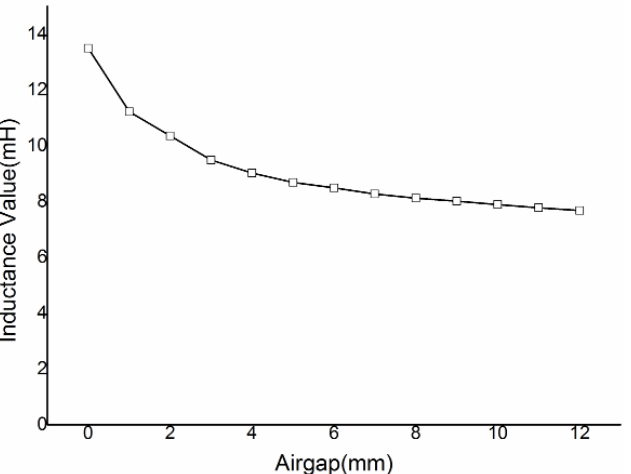
Figure 15. Inductance variation curve with air gap variation of the excitation sensor and the steel